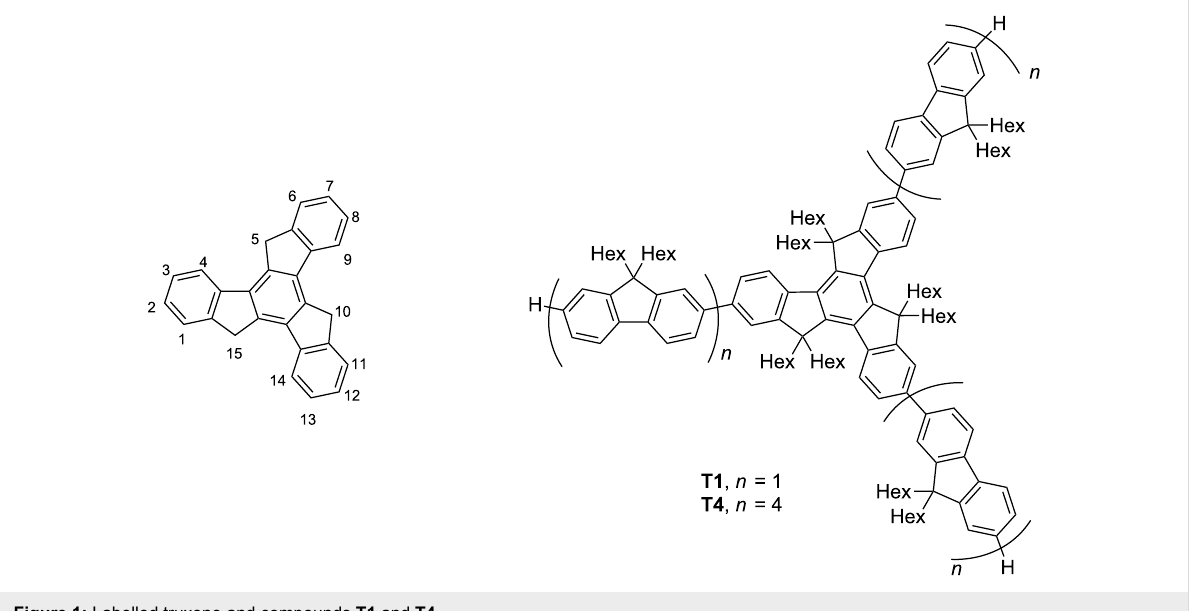
Figure 1: Labelled truxene and compounds T1 and T4 .